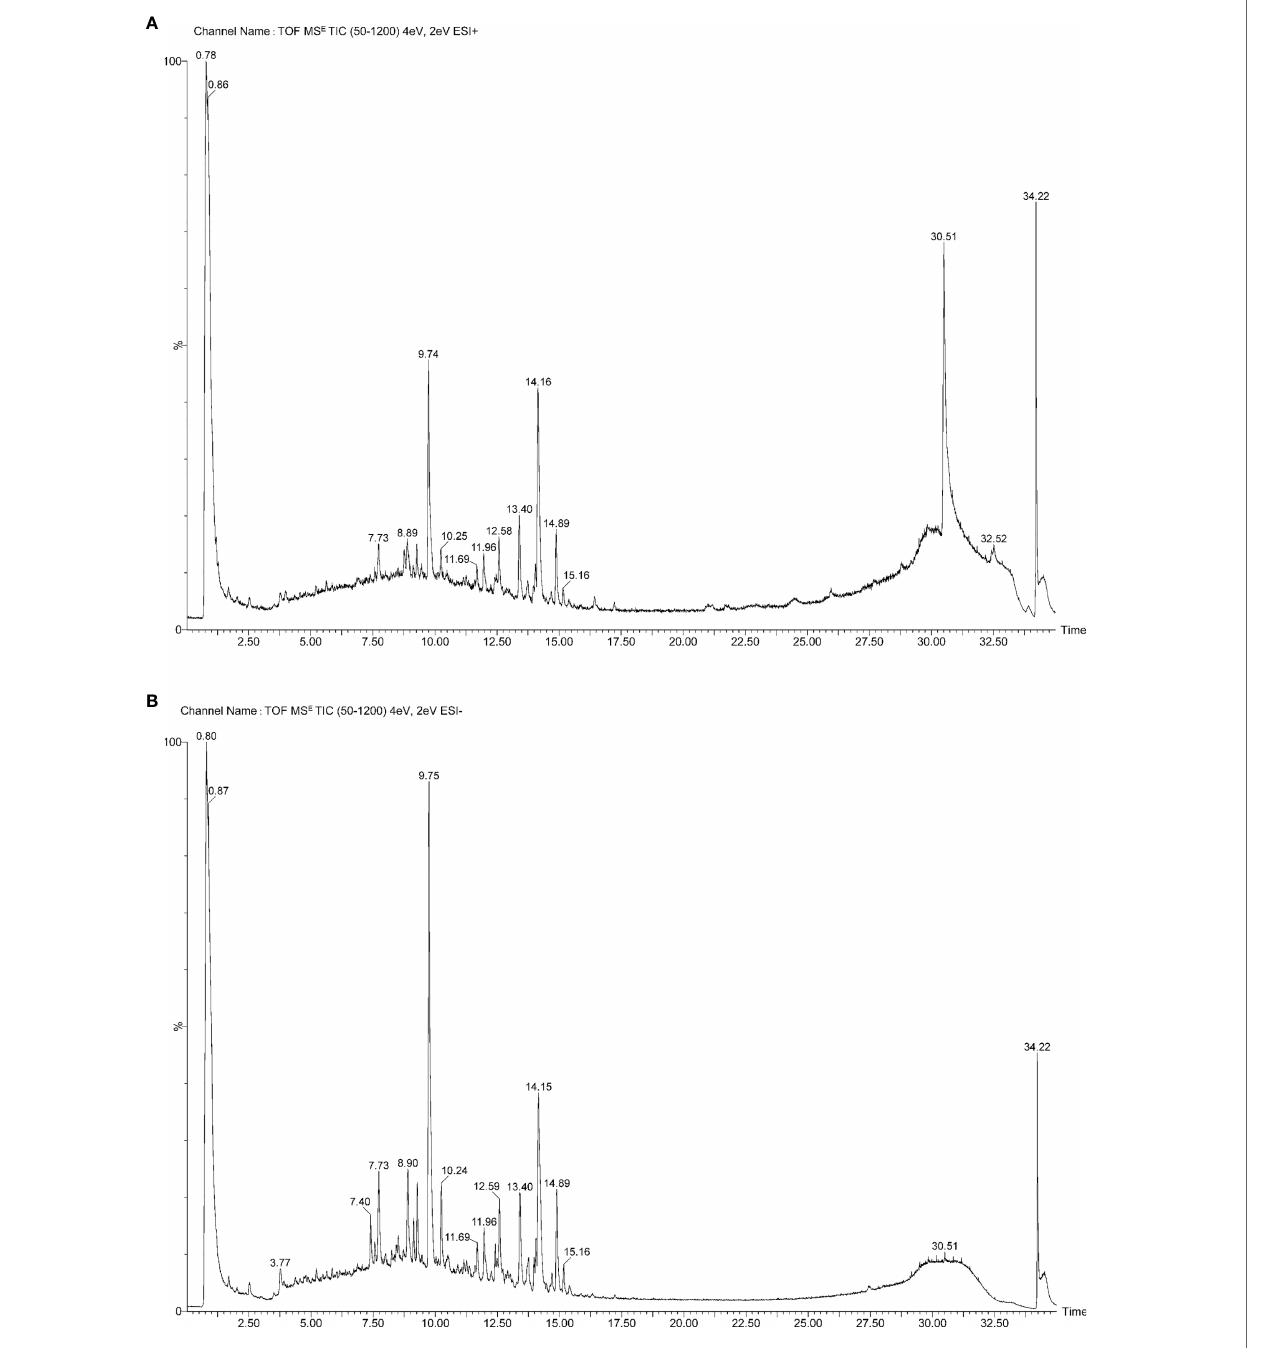
Comparison of Expression Levels of Smo, IL-6, and IL-8 in Gastric Tissue of Rats in Different Groups The positive expression of Smo was mainly located on the cell membrane and in the cytoplasm. Microscopically, positive cells